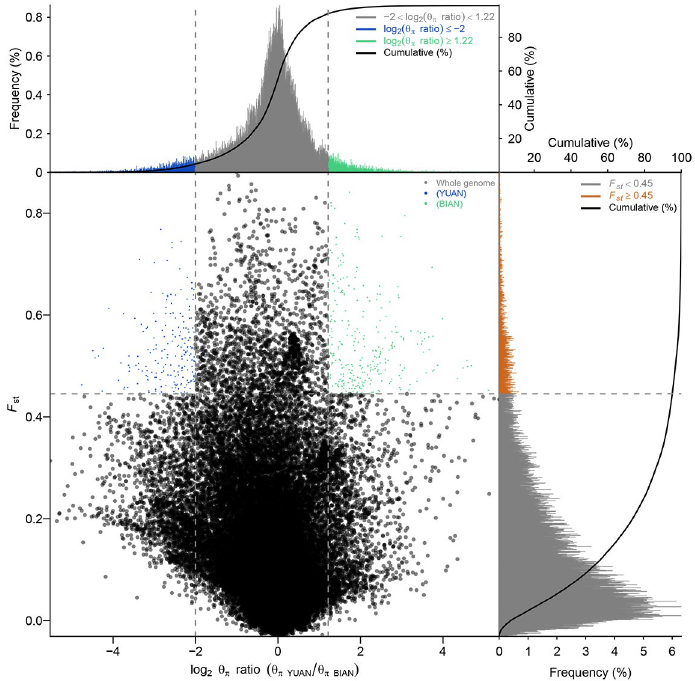
Figure 4. Combination Fst and θπ analysis of two kinds of leaf ball shape B. oleracea accessions using SNPs. The x -axis shows the value of the θπ ratio, and the y -axis shows the value of Fst, which correspond to the above frequency distribution diagram and the frequency distribution diagram on the right. The dot plots in the middle represent the corresponding Fst and θπ ratio values in different windows. The blue and green regions are the top 5% regions selected by θπ, and the red regions are the top 5% regions selected by Fst.